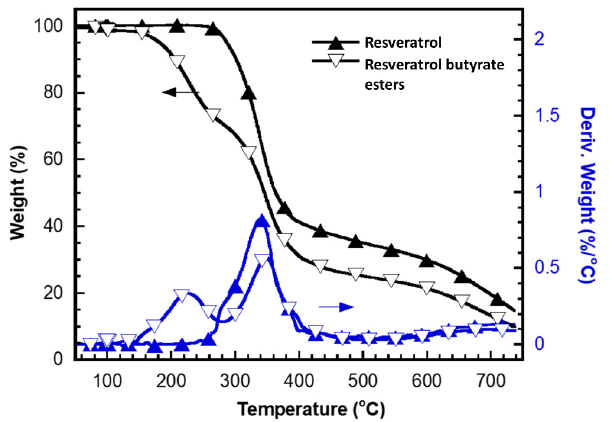
Figure 5. Thermograms of resveratrol and resveratrol butyrate esters under nitrogen from 50 °C to 750 °C.